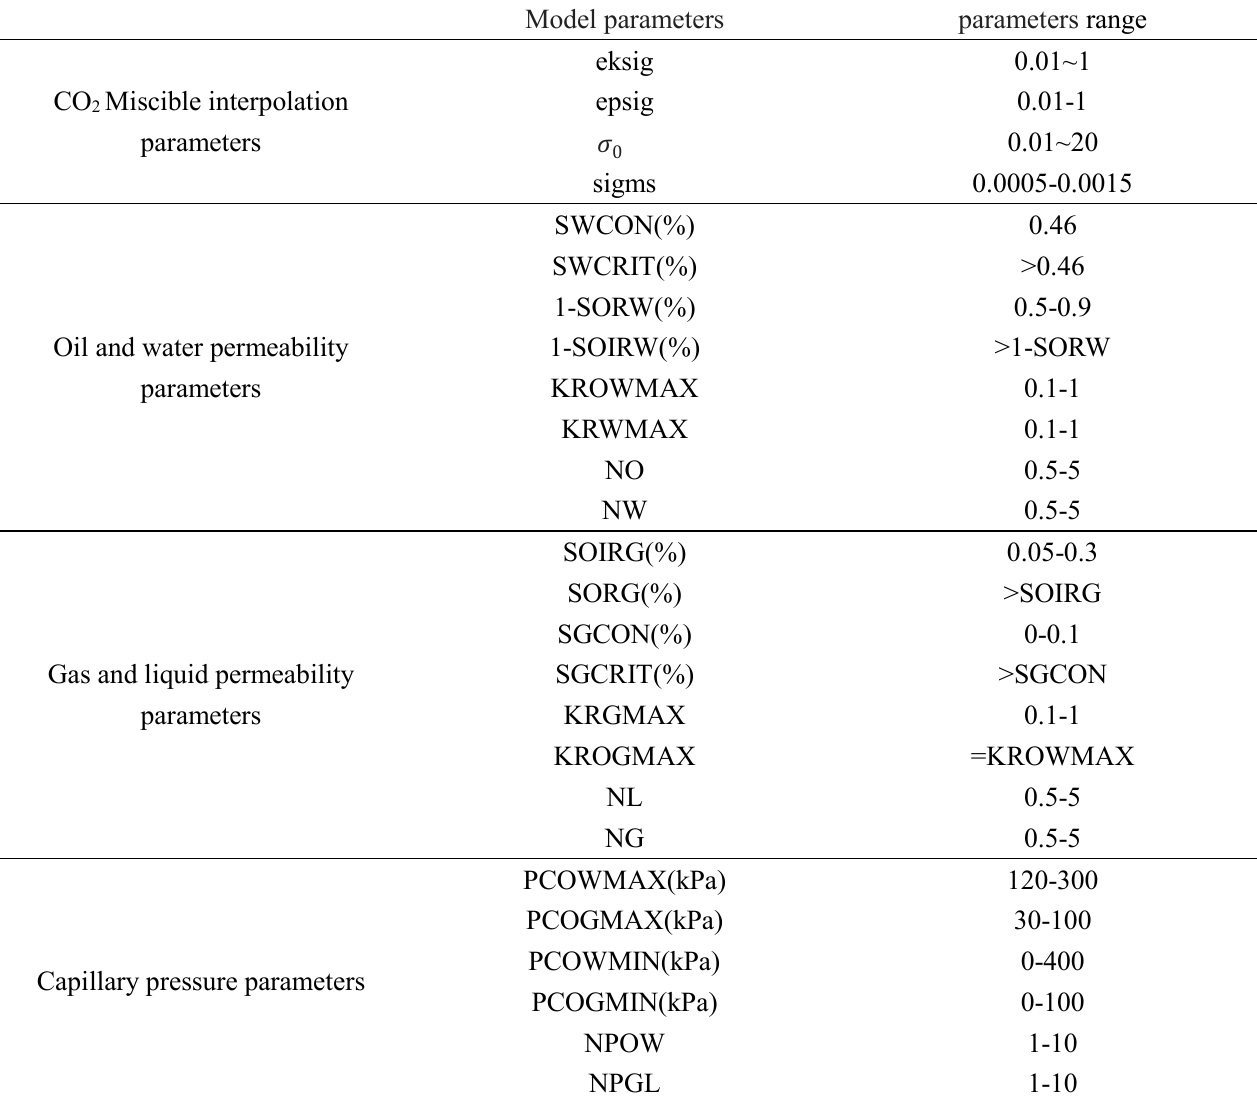
Table 3—Model parameters and their